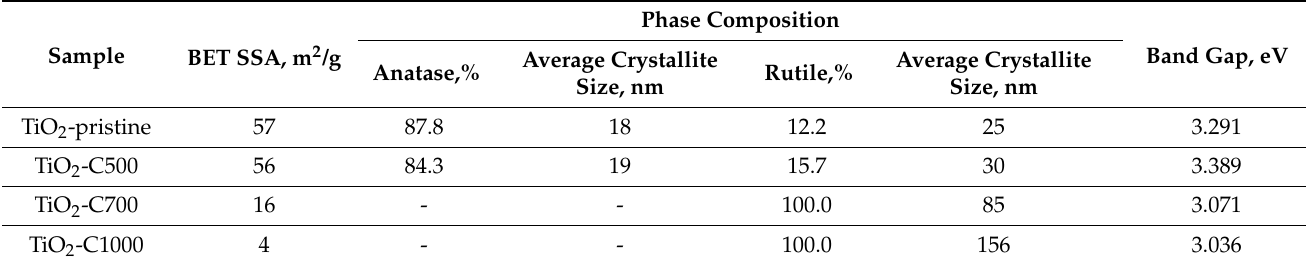
Table 1. Physicochemical properties of TiO 2 samples.